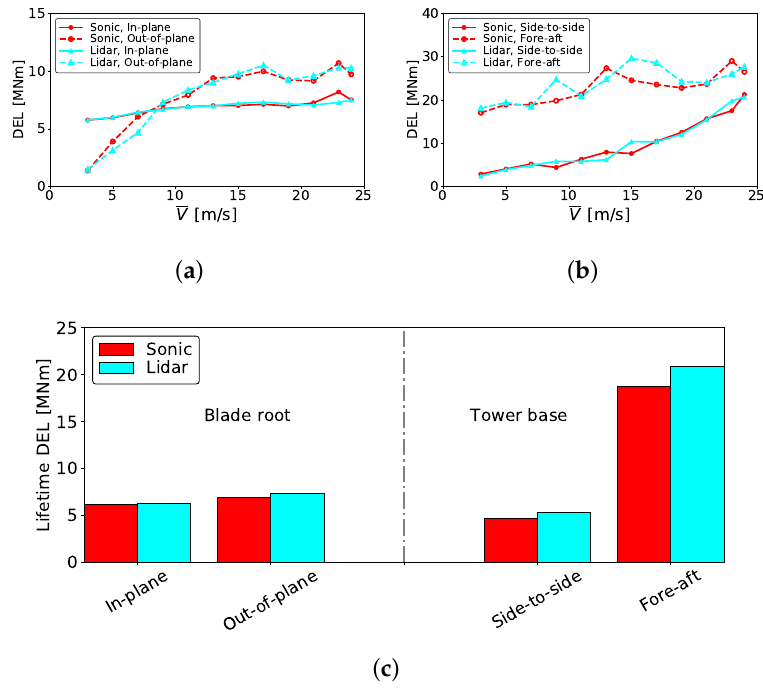
Figure 18. Comparison of DELs computed using the distribution of wind speed and turbulence intensity of the sonic anemometer and the LiDAR measurements. ( a ) DELs for the blade root bending moment; ( b ) DELs for the tower base moment; ( c ) Lifetime DELs (vertical line separates the blade root and the tower base